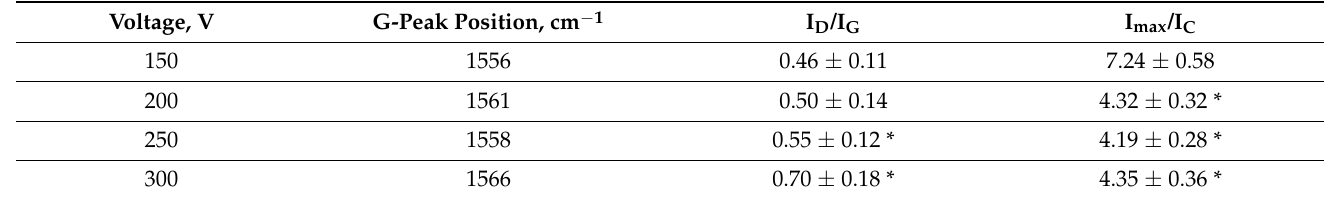
Table 2. Parameters of Raman spectra of the obtained materials. Voltage,